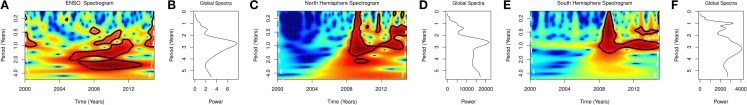
Spectral of influenza-like illness and ENSO. (A) Spectrogram of ENSO. (B) Global spectra of ENSO. (C) Spectrogram of influenza cases in north hemisphere. (D) Global spectra of influenza cases in north hemisphere. (E) Spectrogram of influenza cases in south hemisphere. (F) Global spectra of influenza cases in south hemisphere.